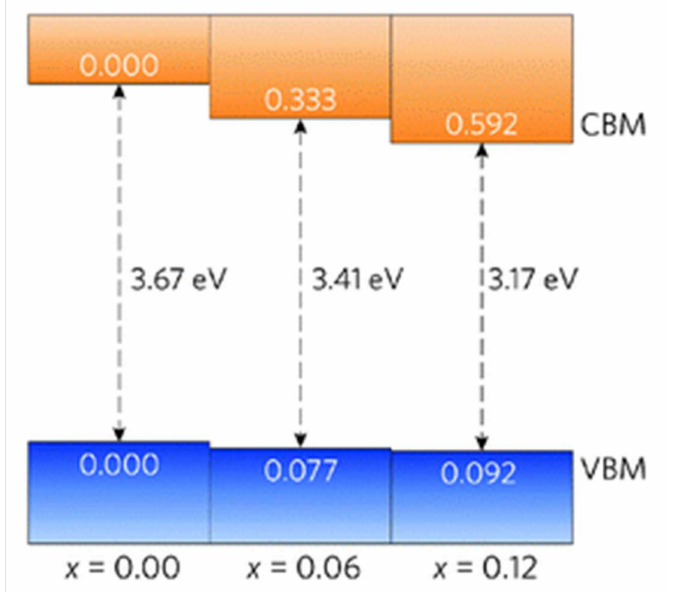
Figure 4. Band alignment scheme for Sn 1 − x Pb x O 2 , where x = 0.00, 0.06, and 0.12. All energies are given relative to an O 1 s state. Adapted with permission from Ref. [50]. Copyright 2016 the Royal Society of